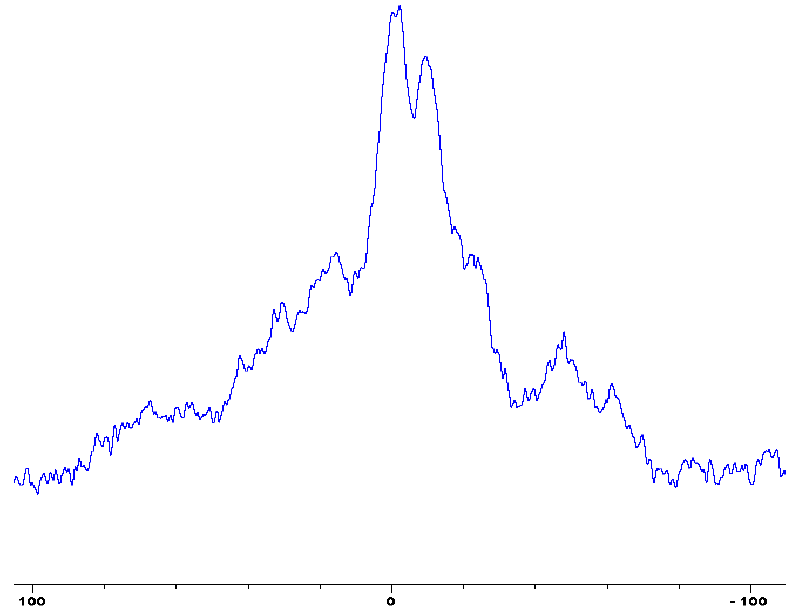
Figure 8. Solid-state 31 P-NMR spectrum of char obtained from fish gelatin + diethylpropylphosphonate (DEPP) (the abscissa denotes the chemical shift values, δ , in ppm and the ordinate corresponds to the signal intensity in arbitrary units).